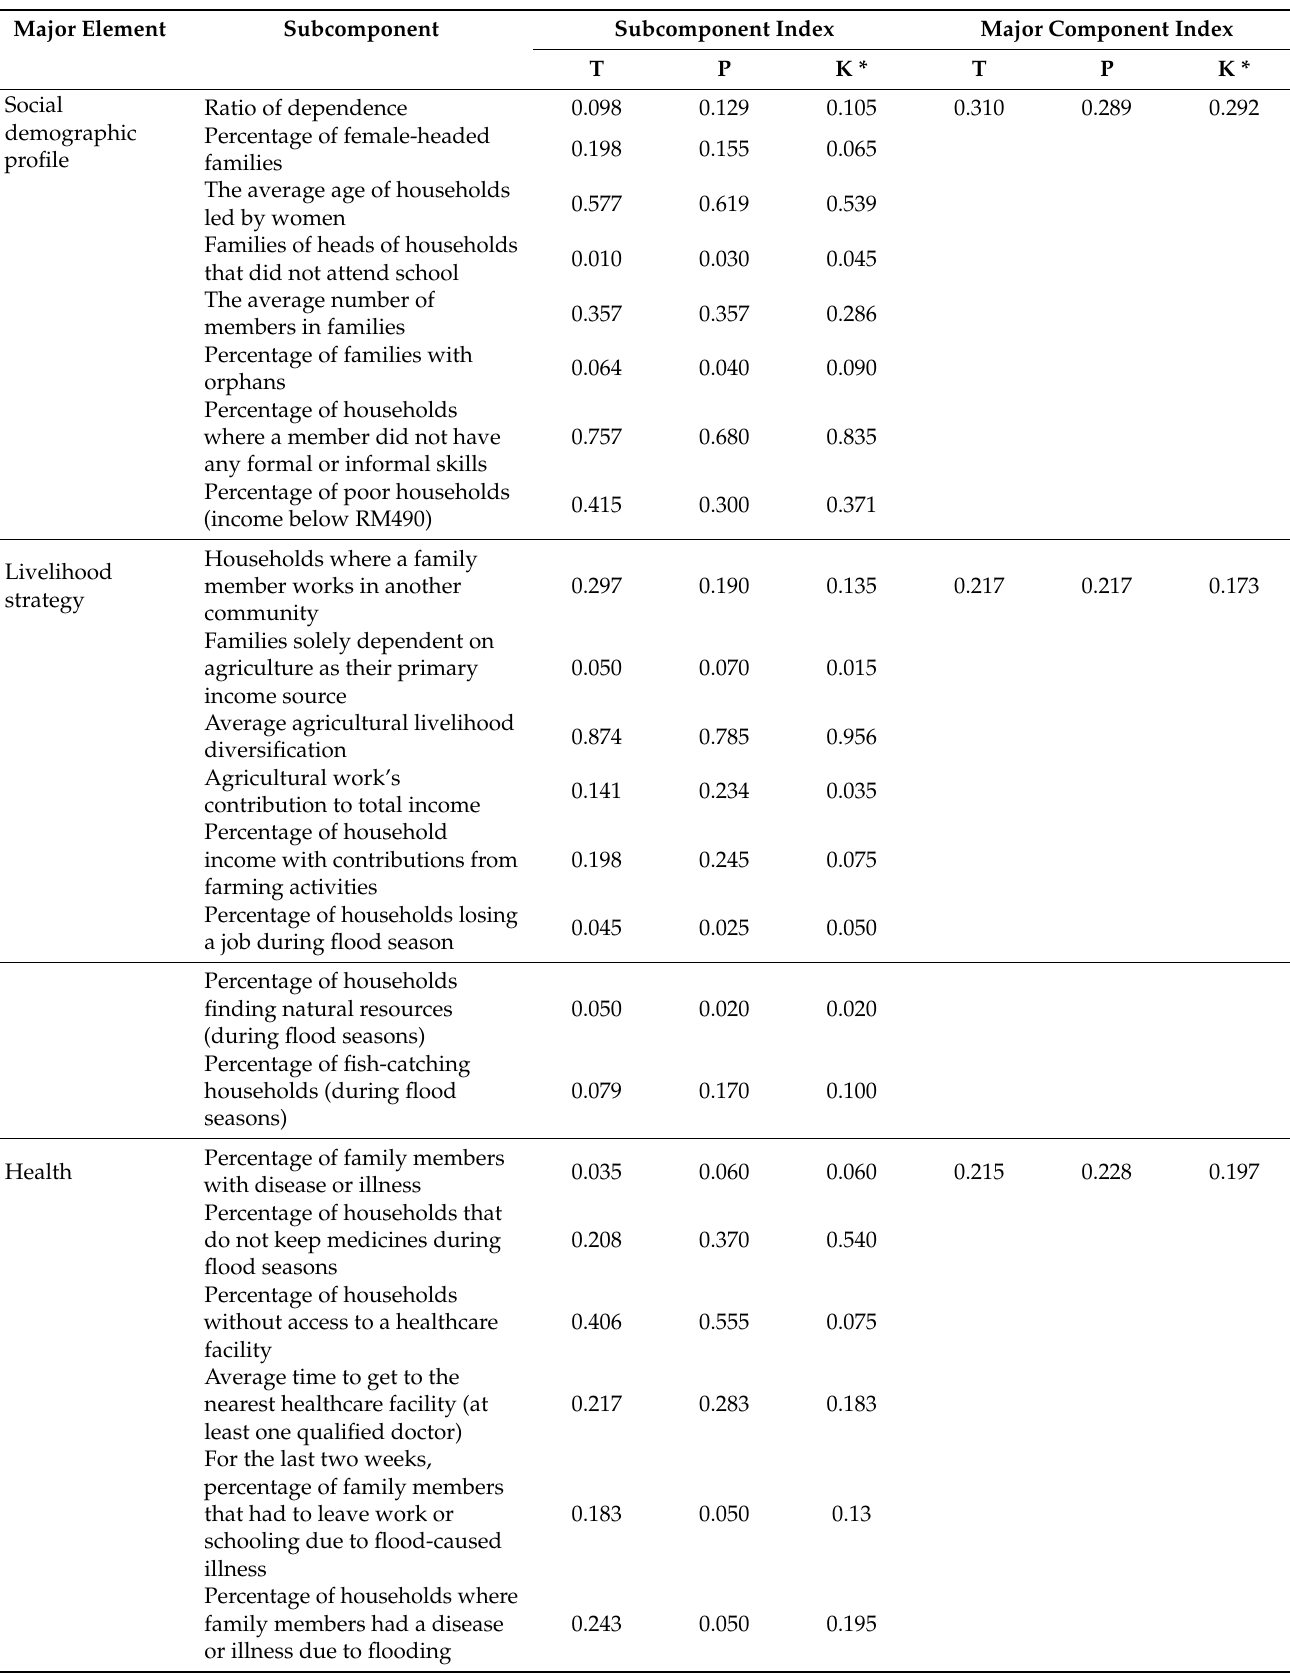
Table 6. Indexed subcomponents, main components, and total LVI for the Districts of Temerloh, Pekan and Kuantan. Major